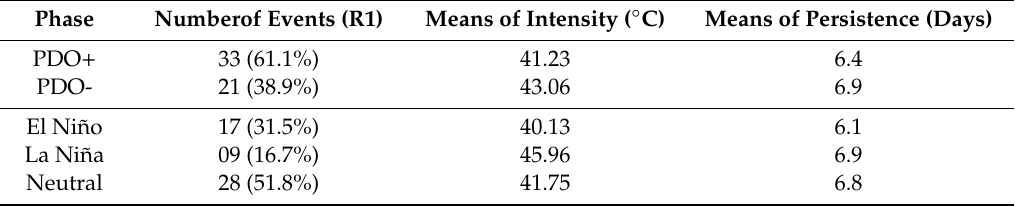
Table 3. Number of heat waves in region1 (R1), the corresponding means of intensity ( ◦ C) and persistence (days) of the events in each phase of the El Niño–Southern Oscillation (ENSO) and Pacific Decadal Oscillation (PDO).